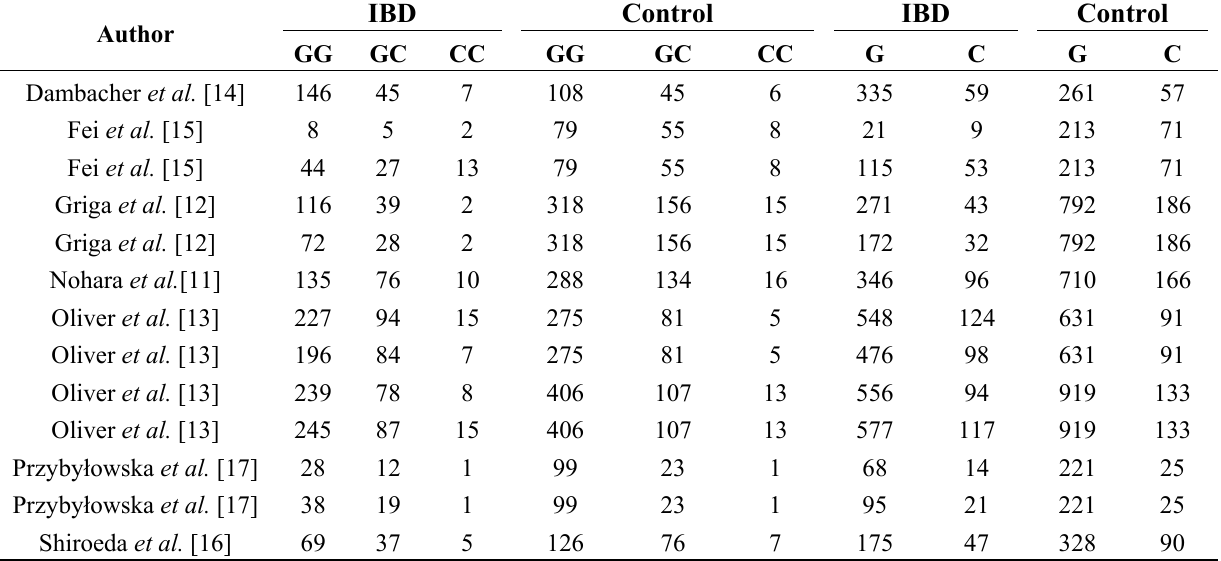
Table 2. Distribution of migration inhibitory factor (MIF) genotype and allele among inflammatory bowel disease (IBD) patients and